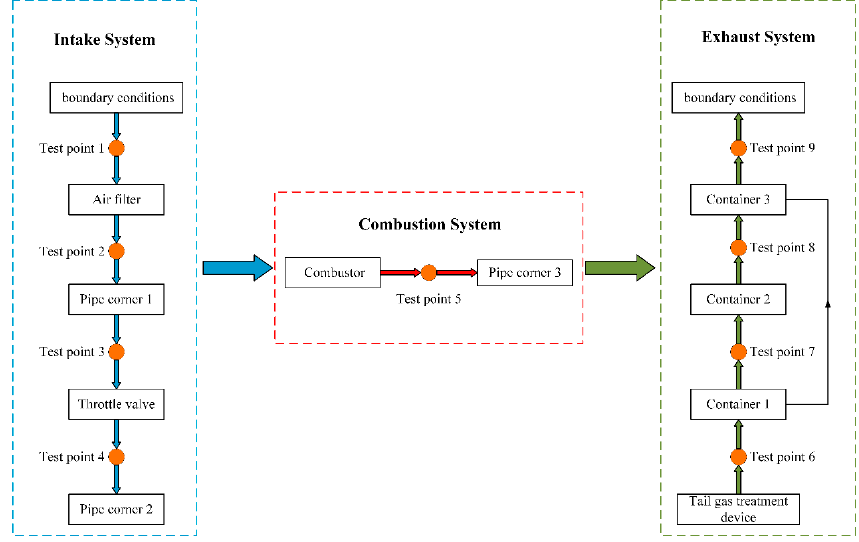
Figure 4. 1D gas-dynamic model.